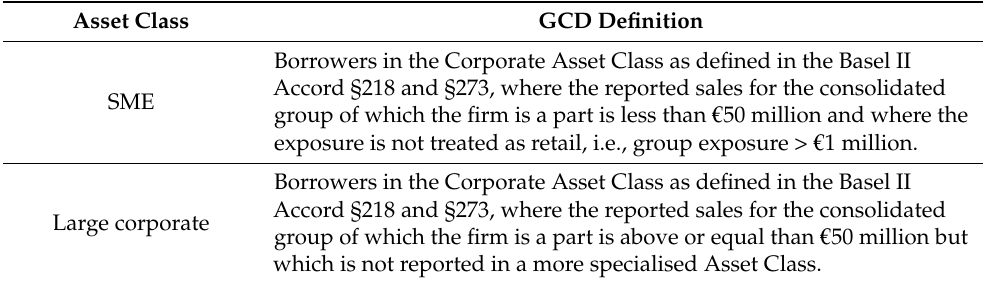
Table 1. GCD definition of the asset classes (GCD 2019).